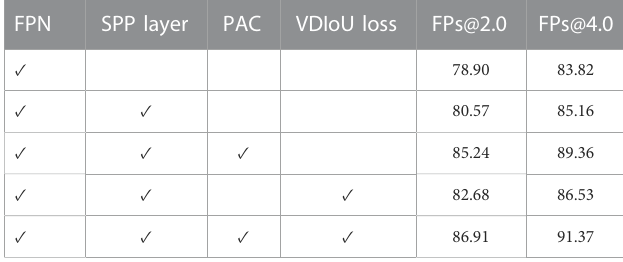
TABLE 5 Ablation study of our approach on the DeepLesion dataset.